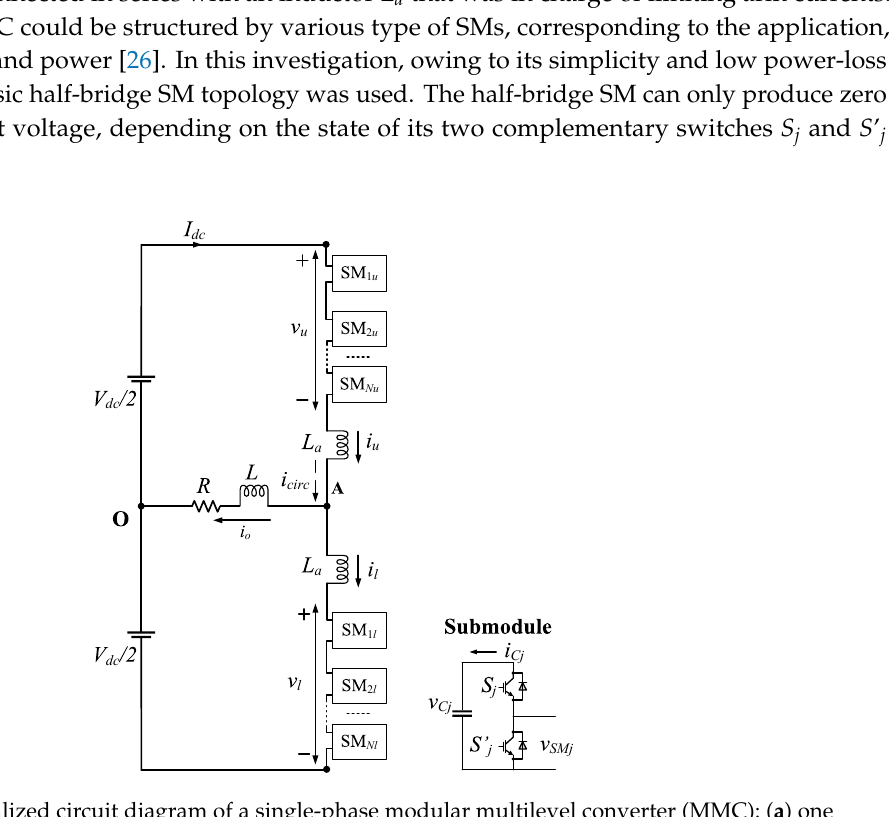
Figure 1. Generalized circuit diagram of a single-phase modular multilevel converter (MMC): ( a ) one phase of the MMC; ( b ) the half-bridge submodule (SM).